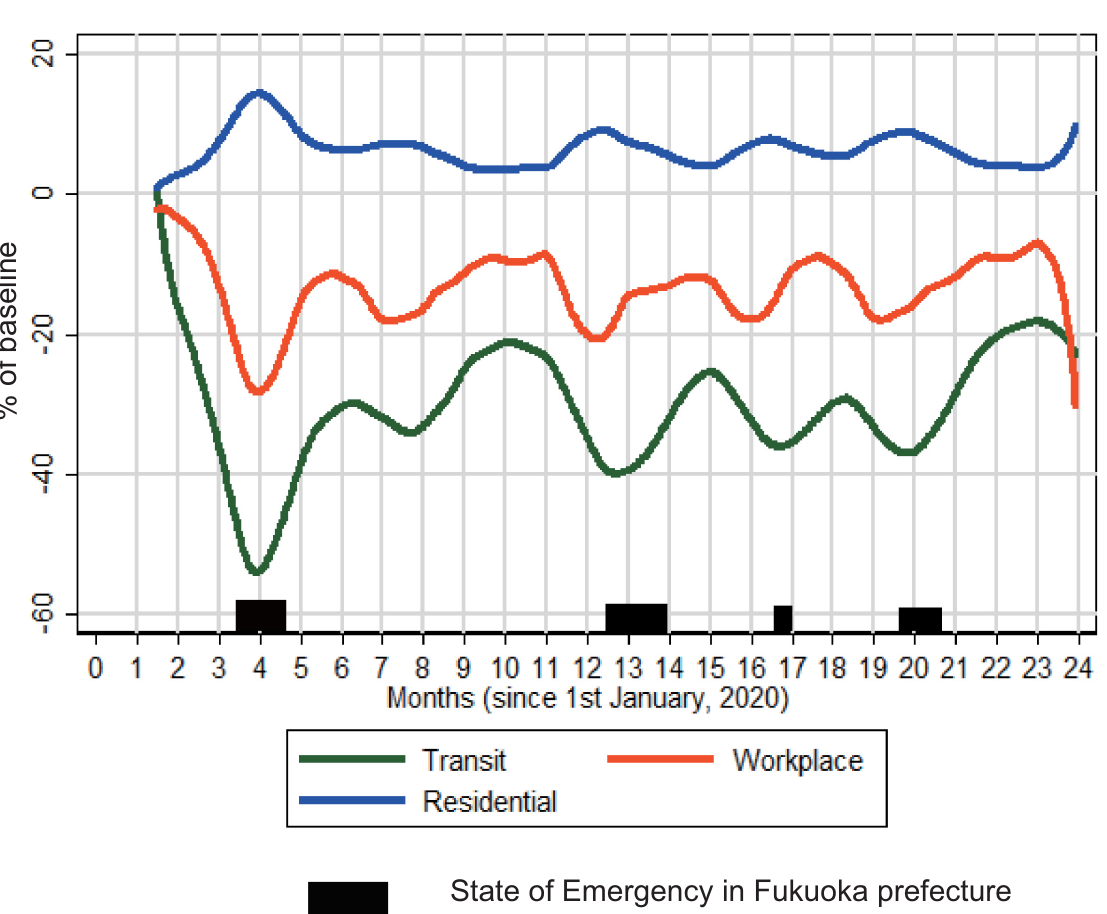
Fig 1. Indicators of community mobility in Fukuoka prefecture. Daily data for Fukuoka prefecture was downloaded from the Community Mobility Report [38]. Time spent in residential areas, workplaces, and transit stations were represented as percentages compared to baseline (3 January– 6 February 2020); values were smoothed using the Lowess method and a 3-day bandwidth.